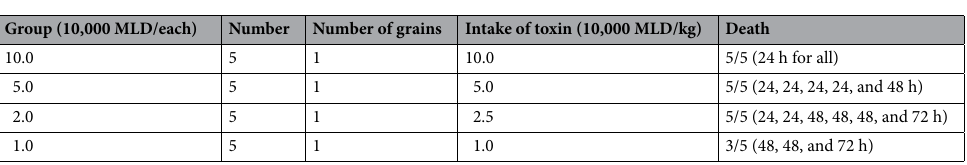
Table 1. Oral toxicity test of different toxic mineralized toxin particles on mice.